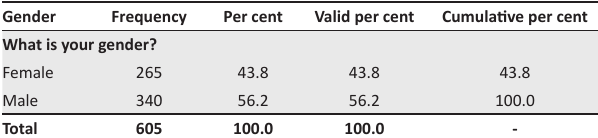
Table 1 indicates the gender composition of the sample with males constituting the majority at 56.2 % compared with females at 43.8 % . Table 2 indicates the race composition of the sample with the mixed race in the majority constituting 38.5 % followed by the TABLE 1: Participants’ gender.